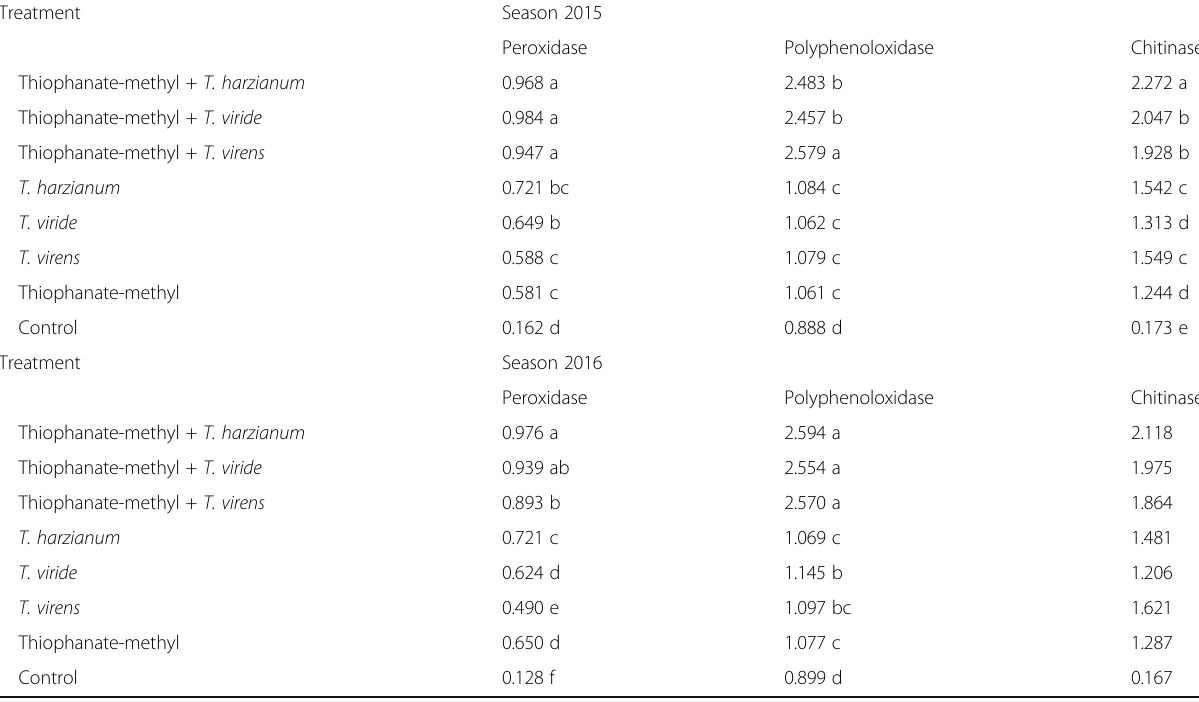
Table 5 Effect of soil application with Trichoderma spp. and seed coating with thiophanate-methyl employed either alone or in combination on the activity of peroxidase, polyphenoloxidase, and chitinase enzymes of dry bean plants grown under field condition